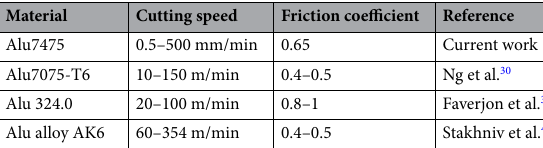
Table 2. Comparison of the values of the friction